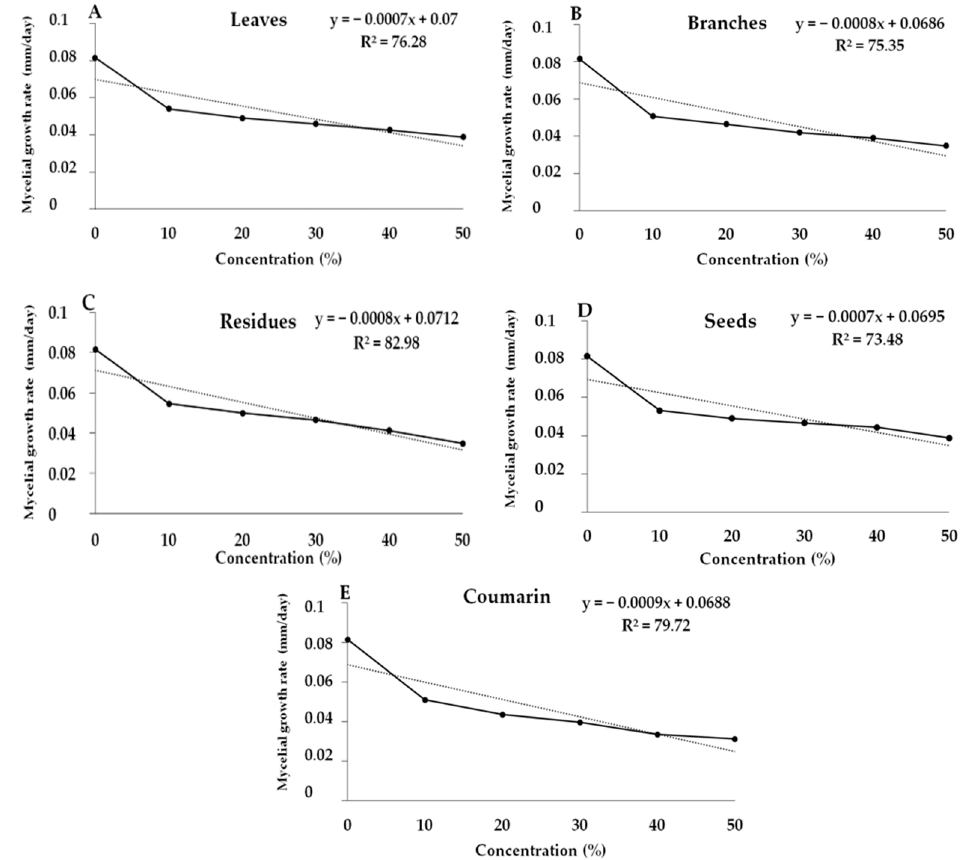
Figure 5. Regression analysis of the mycelial growth rate of Colletotrichum musae subjected to different concentrations of ethanolic extracts of Dipteryx punctata and of the coumarin standard. ( A ) Extract from the leaves. ( B ) Extract from branches. ( C ) Extract from residues. ( D ) Seed extract. ( E ) Coumarin standard.